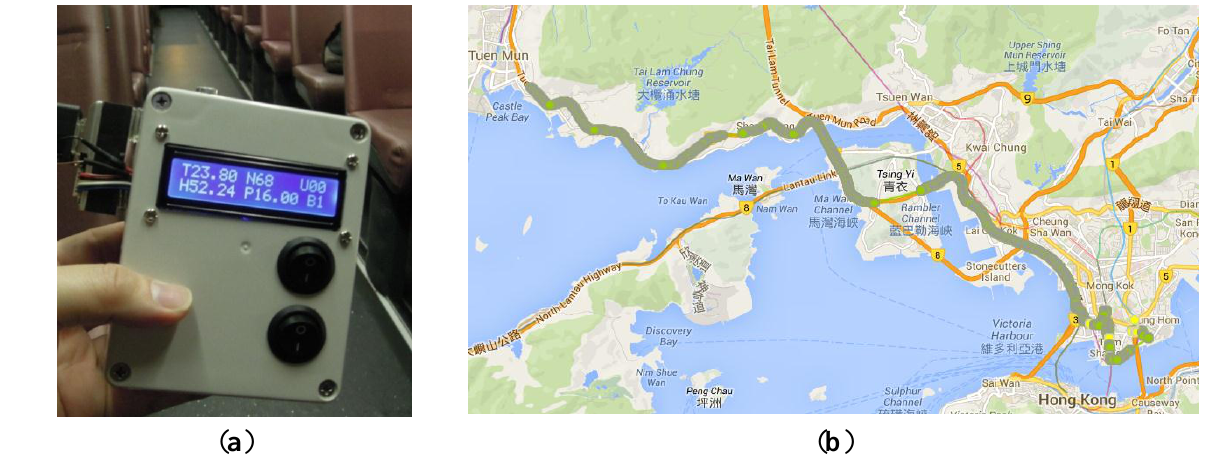
Figure 13. ( a ) IEMD measures the environment quality in bus compartment; ( b ) data collection in bus compartment.